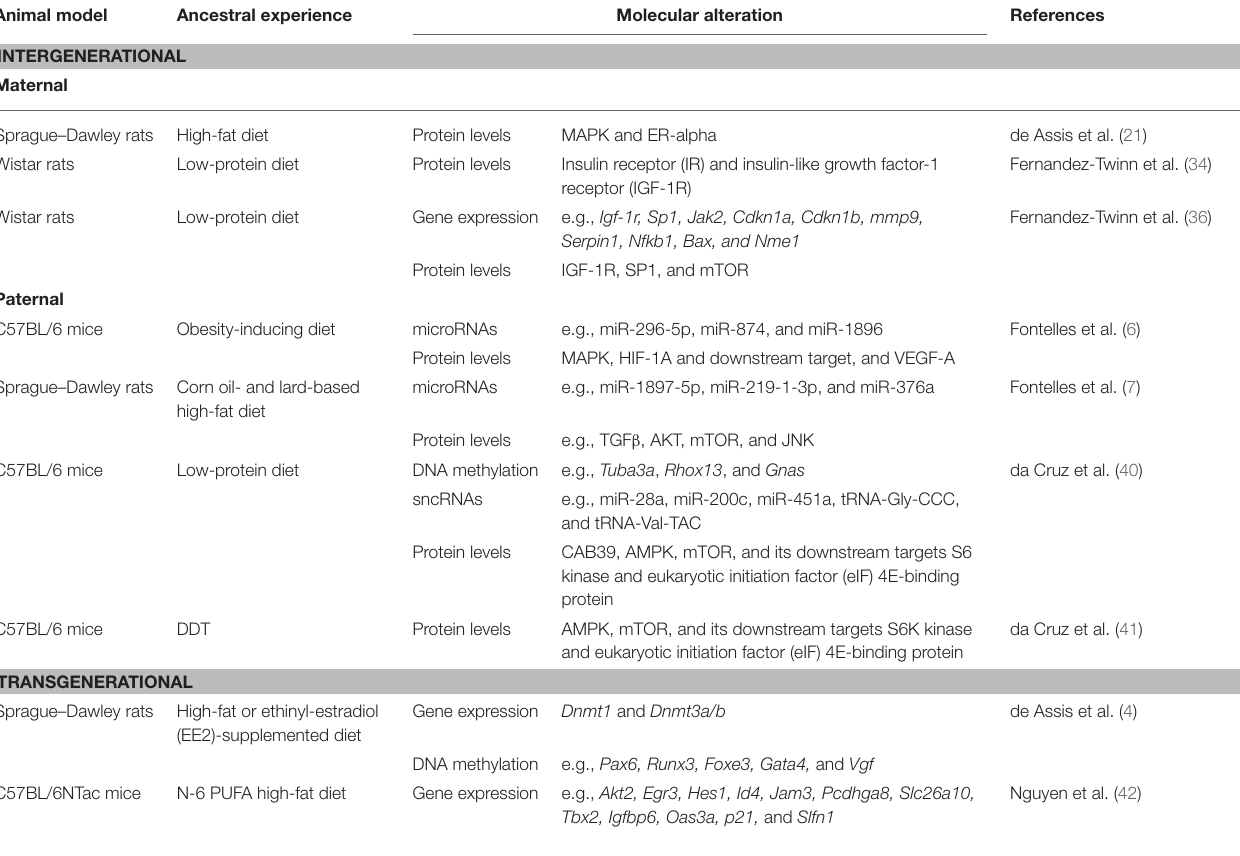
TABLE 1 | Parental exposure-induced molecular changes in offspring’s mammary